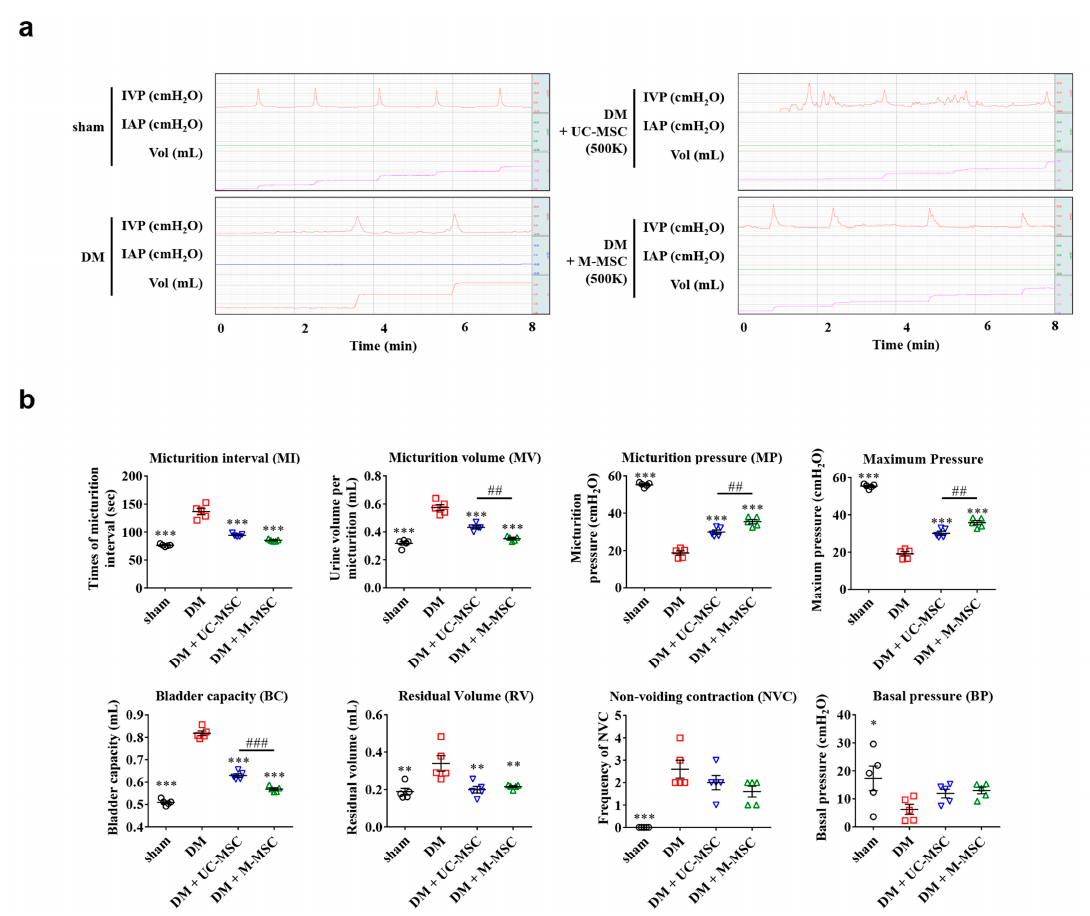
Figure 5. Superior efficacy of M-MSCs to UC-MSCs. ( a ) Representative awake cystometry results and ( b ) quantitative voiding data 1 week after injection of M-MSCs or UC-MSCs (0.5 × 10 6 cells; 500 K) into the bladders of DM rats. All data are presented as the mean ± SEM ( n = 5). Data were analyzed using a one-way ANOVA with Bonferroni post-hoc comparison (* p < 0.05, ** p < 0.01 and *** p < 0.001 relative to DM group; ## p < 0.01, ### p < 0.001 M-MSC vs. UC-MSC groups). The exact experimental and